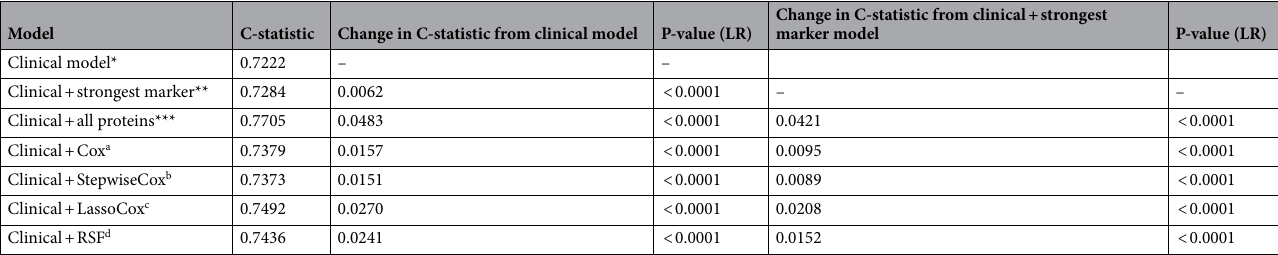
Table 3. Performance metrics of different Cox regression models where proteins were selected for inclusion by using a two-step random-split approach in the MDCS-CVA (N = 3,918). *Covariates included in the model were age, sex, smoking status, BMI, educational level, history of hypertension, prevalent diabetes mellitus, C-reactive protein, HbA1c, and LDL-cholesterol. **Covariates and growth/differentiation factor-15 (GDF- 15). ***Covariates and all proteins (n = 138). a Covariates and 9 proteins (AR, CXCL9, GDF15, GH, HE4, IL6, NTproBNP, SCF, UPAR) associated (P < 0.05) with all-cause mortality in a Cox regression model after adjustment for covariates in both random samples of the MDCS-CVA. b Covariates and 6 proteins (GDF15, CASP3, EGFR, EZR, HE4, NTproBNP) associated (P < 0.05) with all-cause mortality with mutual adjustment in both random samples of the MDCS-CVA using a stepwise Cox regression with backwards elimination of proteins with P < 0.05. MPO was excluded due to diverging associations with all-cause mortality in the two random samples. c Clinical variables and 13 proteins (CXCL9, EGFR, EZR, GDF15, GH, HE4, KLK6, MB, NTproBNP, SCF, TIM, TRAIL, UPAR) retained in both random samples of the MDCS-CVA using a Lasso penalized Cox regression and lambda minimum for protein selection. d Clinical variables and 21 proteins (FABP4, FasL, GDF15, HE4, HGF, IL12, IL6, mAmP, MMP1, MMP12, MYD88, NTproBNP, PRSS8, PSGL1, PTPN22, PTX3, RAGE, REN, SCF, THPO, TIM) retained in both random samples using a RSF backward elimination